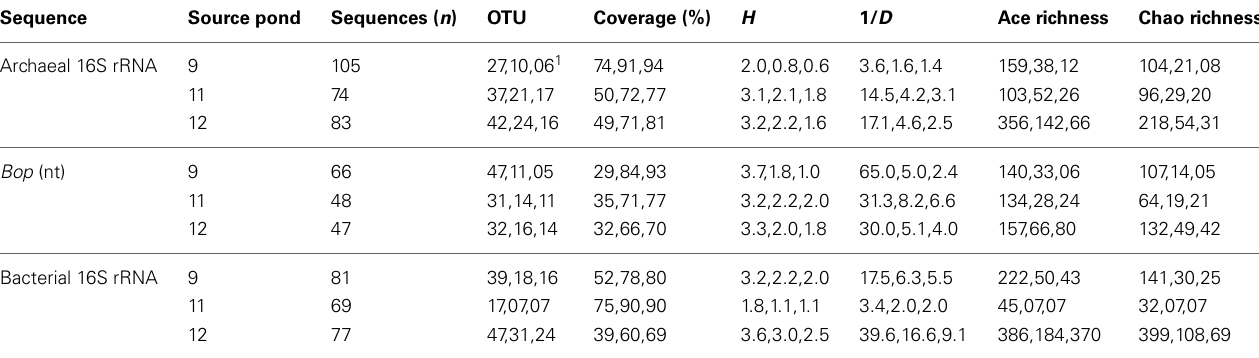
Table 2 | 16S rRNA and bop nucleotide diversity analyses among ESSA source ponds.